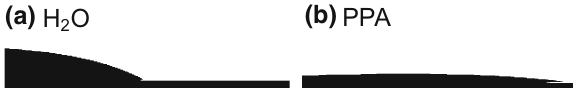
Fig. 3 Photographs illustrating the difference in contact angle on polycrystalline, dense 8YSZ between ( a ) the water based ink and ( b ) the propionic acid based ink. The PPA ink showed better wetting and a lower static contact angle